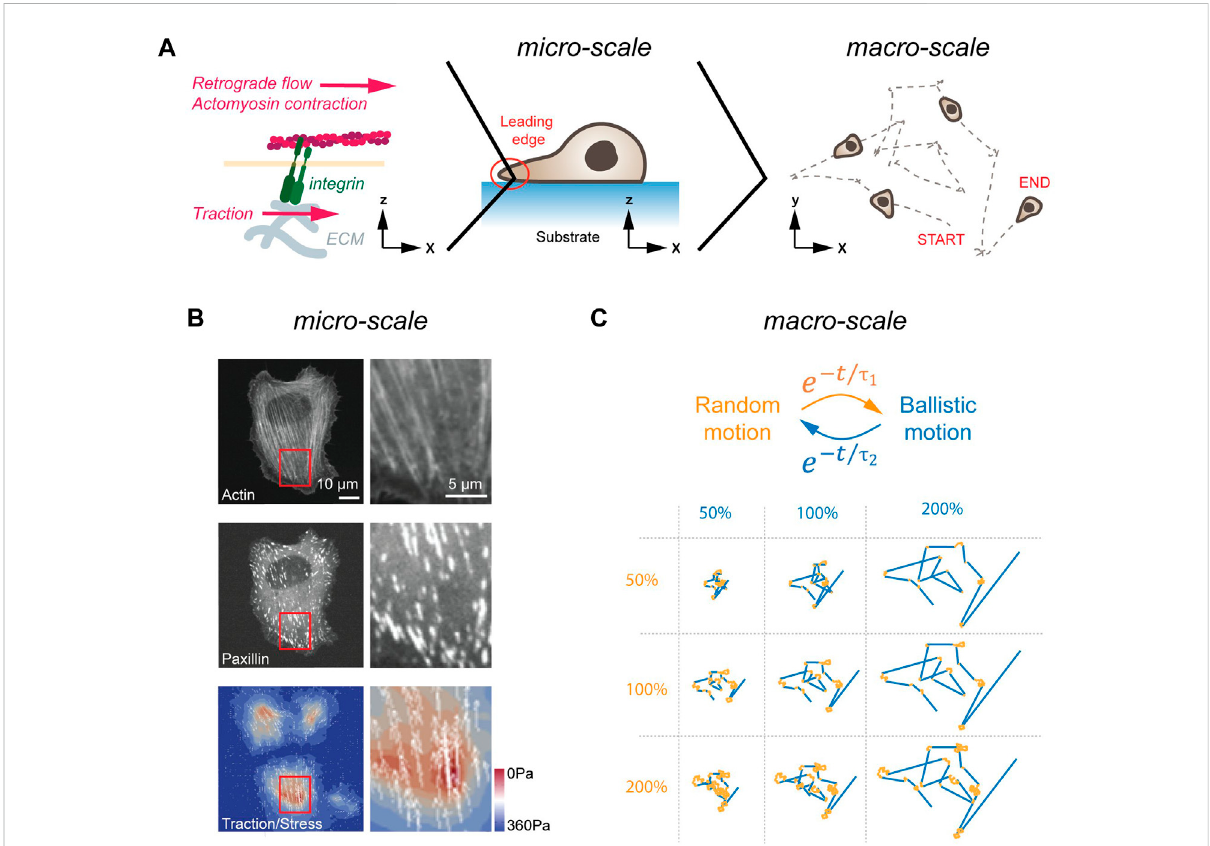
FIGURE 1 Cellmigrationin2D. (A) LEdynamicsin2D.Fromlefttoright,themolecularclutch,theleadingedgeofacellmigrating,andacross-sectionofa cell migrating on a fl at, homogenous surface are shown. The molecular clutch allows to couple the ECM to the cytoskeleton in the presence of tensile forces. The resulting traction is used for cell migration. (B) Traction forces of cells plated on elastic substrates. Image of a cell plated on a soft substrate. Image (left) and magni fi cation of a cell stained for actin (top), and the FA protein paxillin (middle), as well as traction forces are shown (bottom). Scale bars, 10 μ m (left panels) and 5 μ m (right panels). (C) Emerging motion pattern at the macro-scale. Cells transition between phases of random (orange) and ballistic (blue) motion. Single trace for different random (orange, duration in percent) and persistent (blue, duration in percent) lifetimes are shown below. Image in (B) adapted under CC-BY license from Soiné et al.,